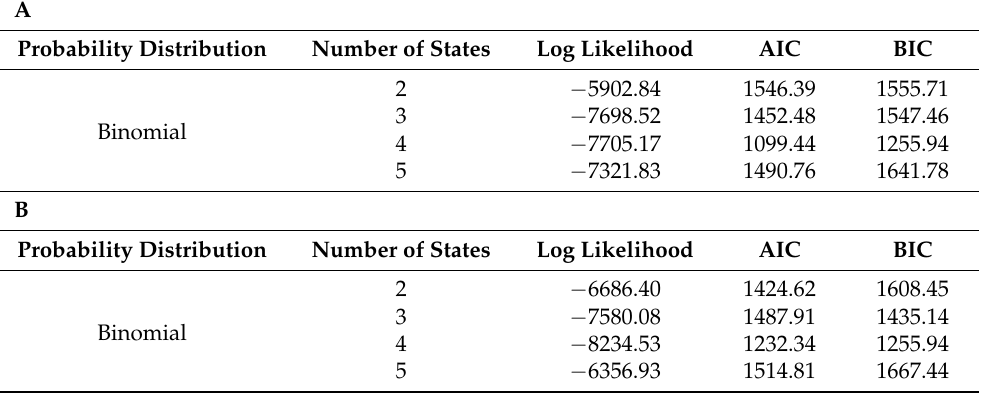
Table 6. A. The optimal number of states for the population without DM2. B. The optimal number of states for the population with